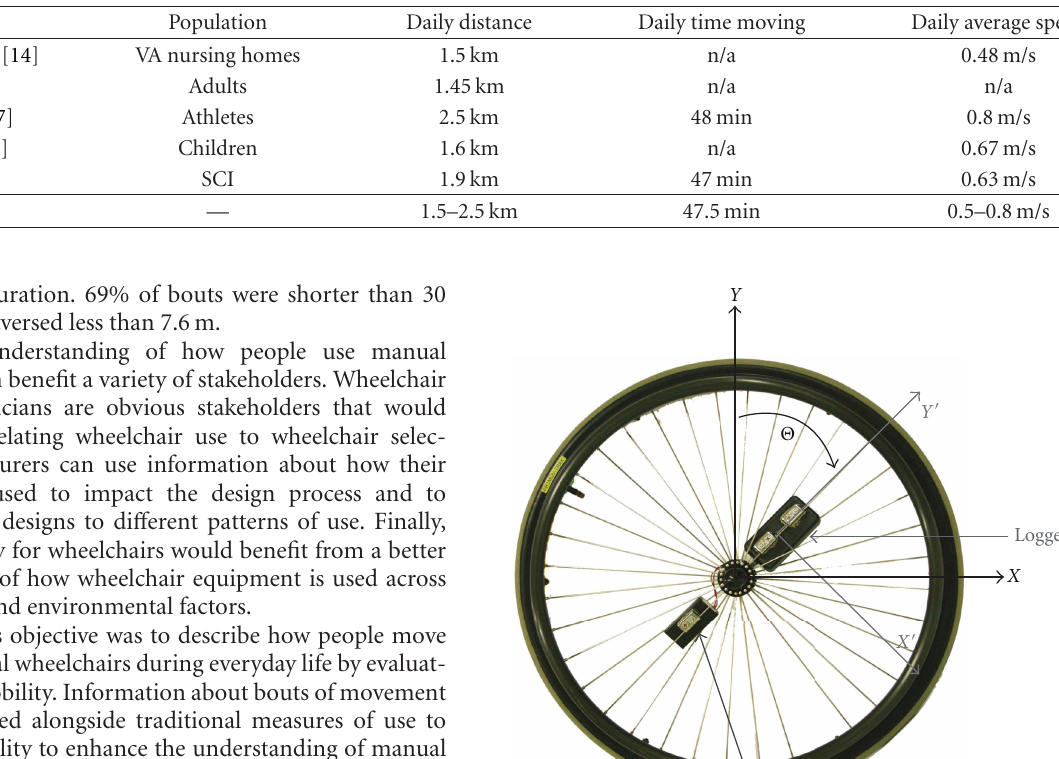
Table 1: Five studies measuring manual wheelchair use in everyday life.